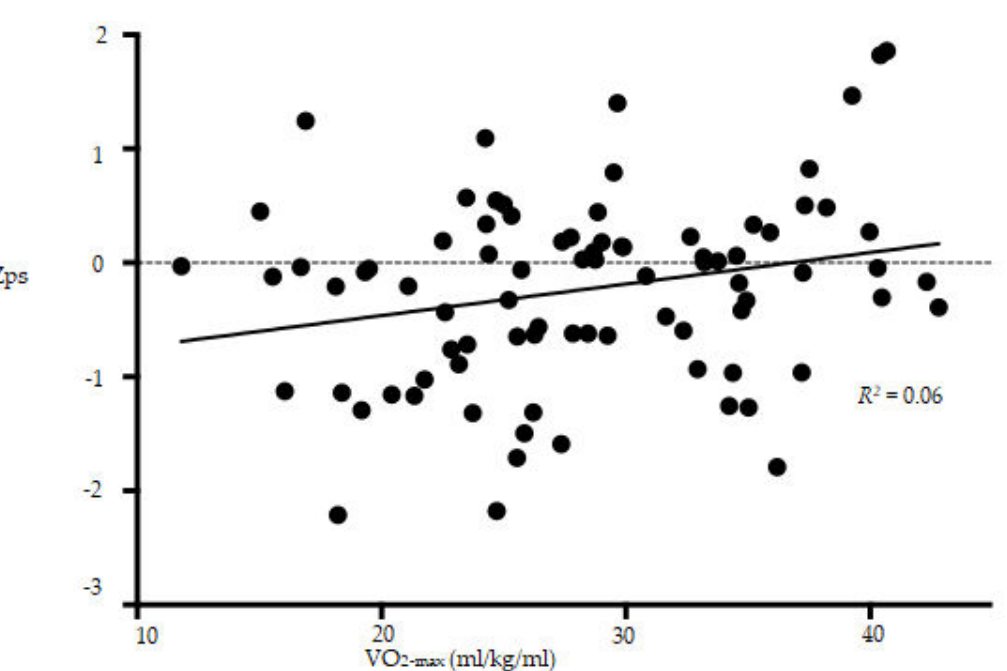
Figure 2. Association between Z ps and aerobic capacity. The association was not significant when adjusted for age, sex, and education years. Z ps : Composite z-score for the Paced Auditory Serial Additional Test (PASAT) and the Symbol Digit Modalities Test (SDMT), VO 2 -max: Maximal oxygen